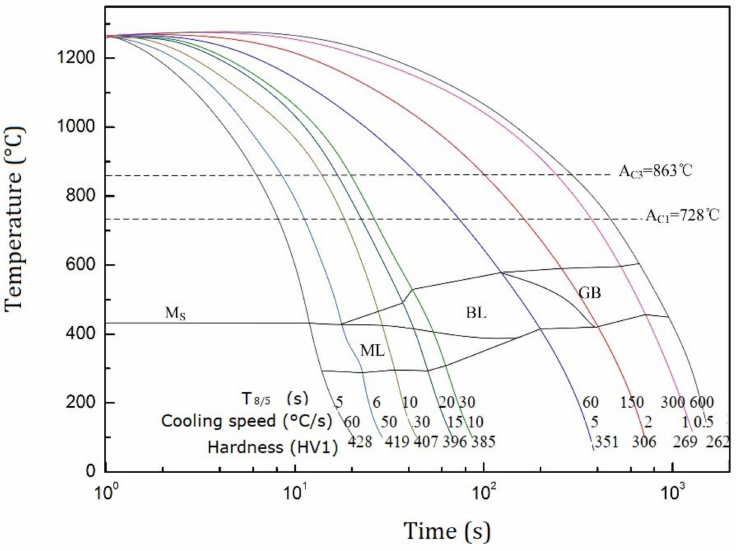
Figure 8. SH-CCT diagram of Q960E